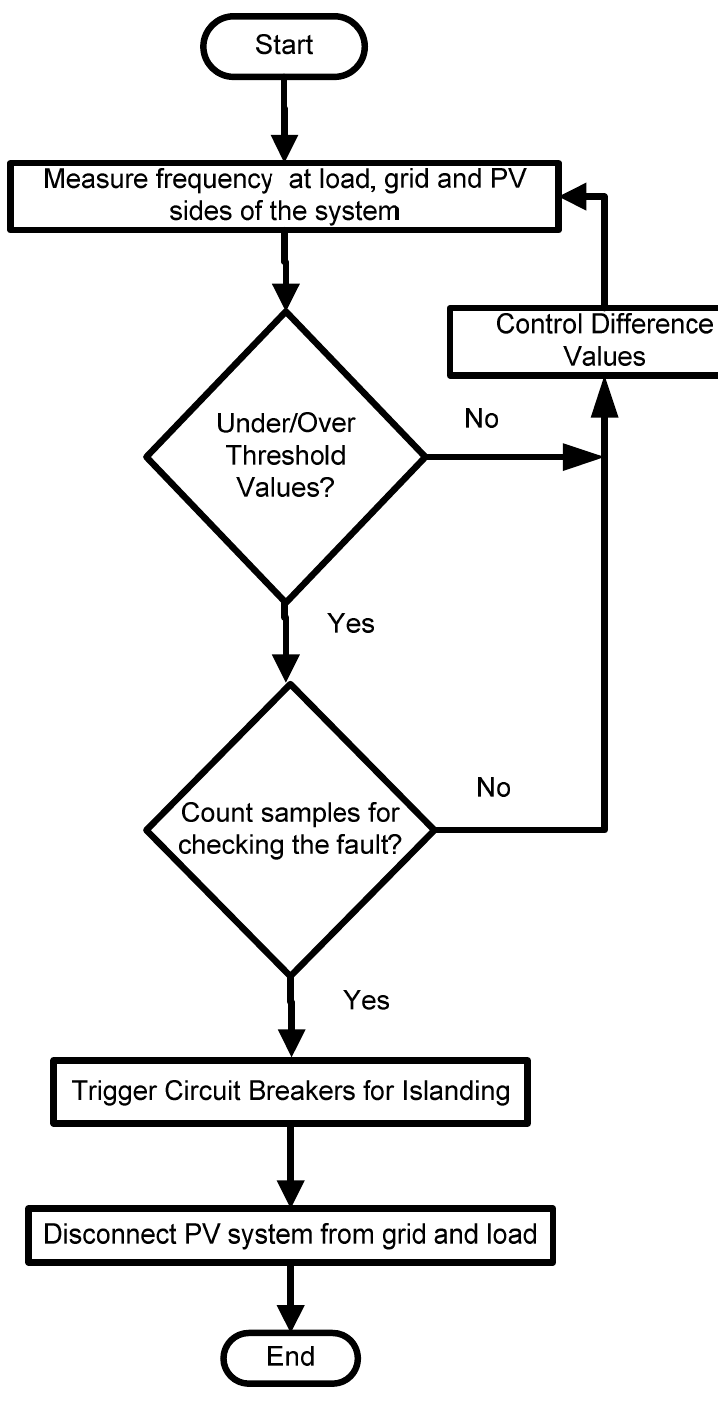
Figure 2. The proposed islanding detection algorithm.